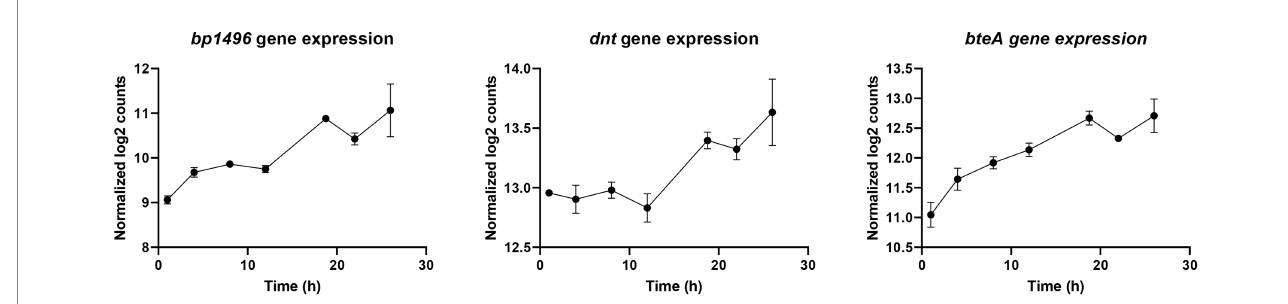
FIGURE 10 Longitudinal expression profiles of bp1496 , dnt , and bteA genes during Bordetella pertussis Tohama I